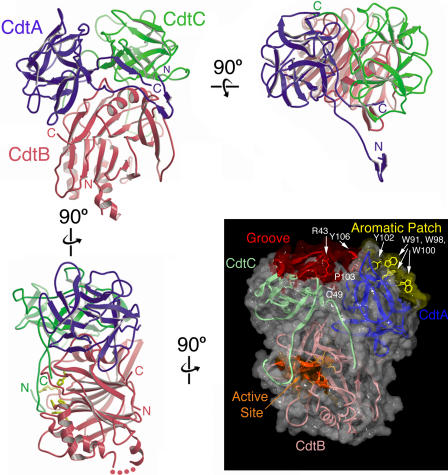
Structure of CDT and Mutational LocationsFour alternative orientations of the crystal structure of the H. ducreyi CDT are shown as a ribbon cartoon tracing the three polypeptide chains. CdtA, CdtB, and CdtC are shown in blue, red, and green, respectively. Red dots indicate CdtB peptide not modeled due to disorder. N, NH2-terminus; C, COOH-terminus. The final image shows a partially transparent surface illustration focusing on the groove (red) and aromatic patch (yellow). Residues mutated for cell binding studies are indicated in white.